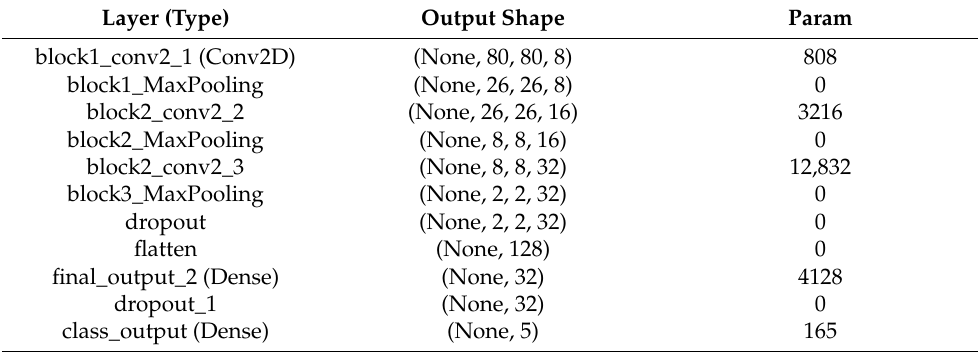
Figure 6. CNN architecture diagram. Table 2. Parameters of the proposed CNN model.